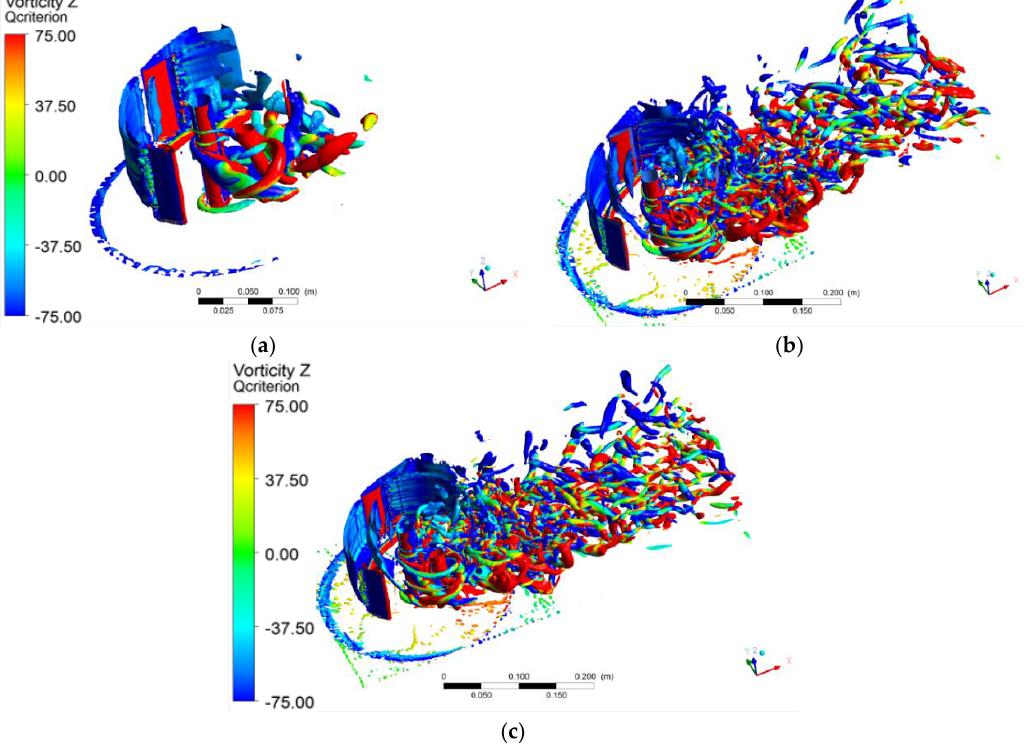
Figure 15. Iso-surface contours of Q-criterion for the ( a ) URANS, ( b ) DES and ( c ) DDES models, at λ = 2.